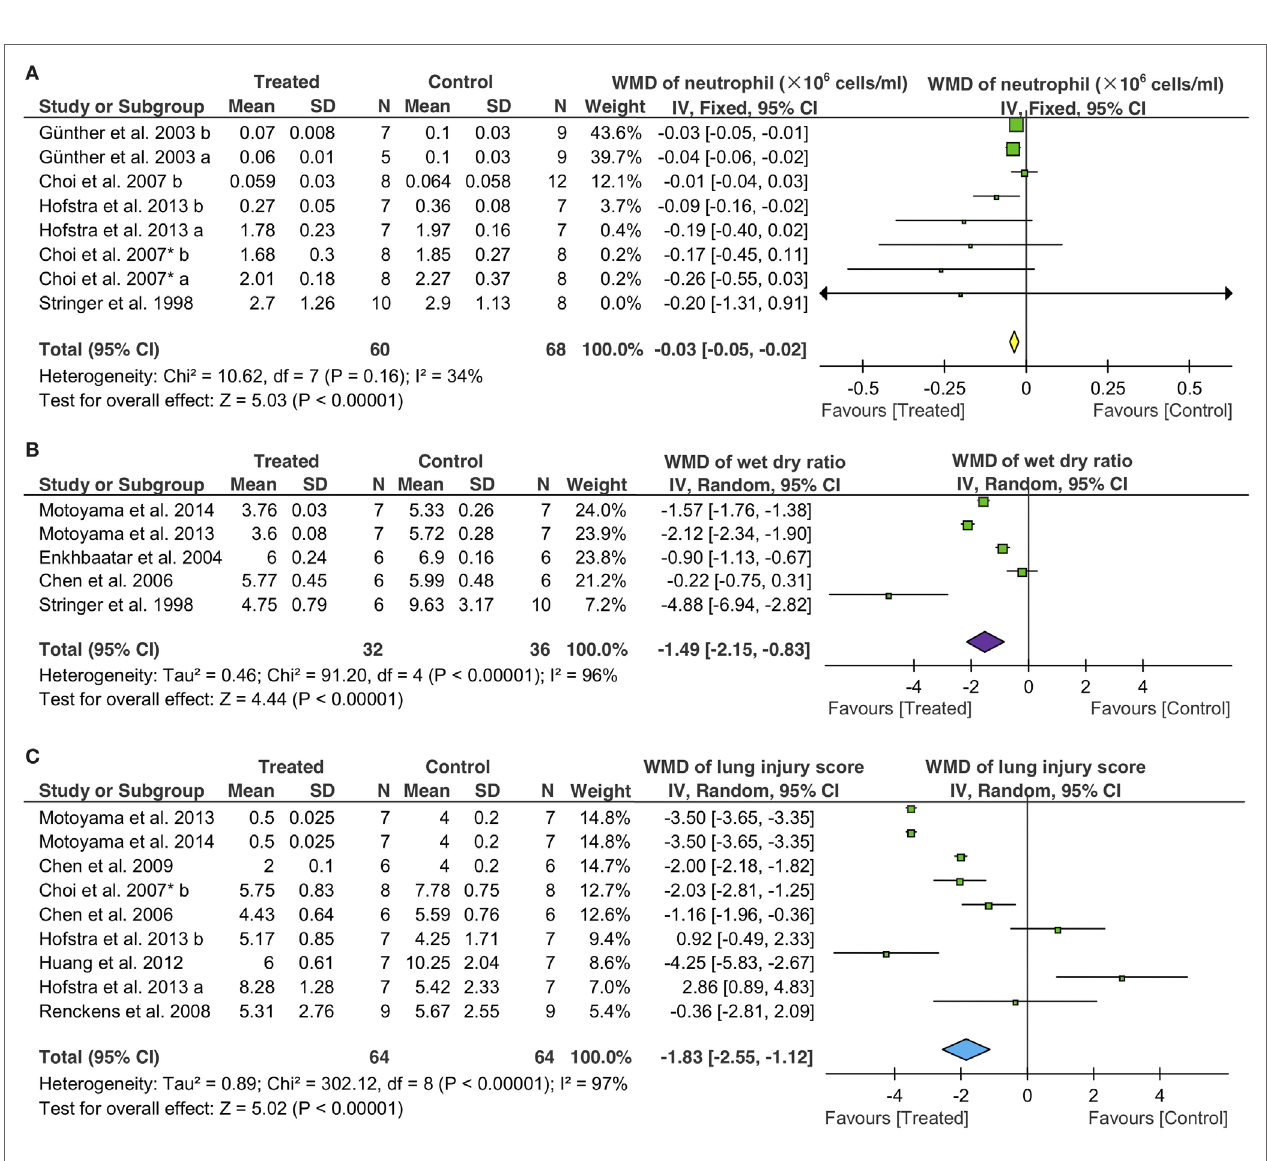
FiGURe 6 | Effects of fibrinolytic therapy on lung neutrophils (a) , lung water content (B) , and lung injury score (c)